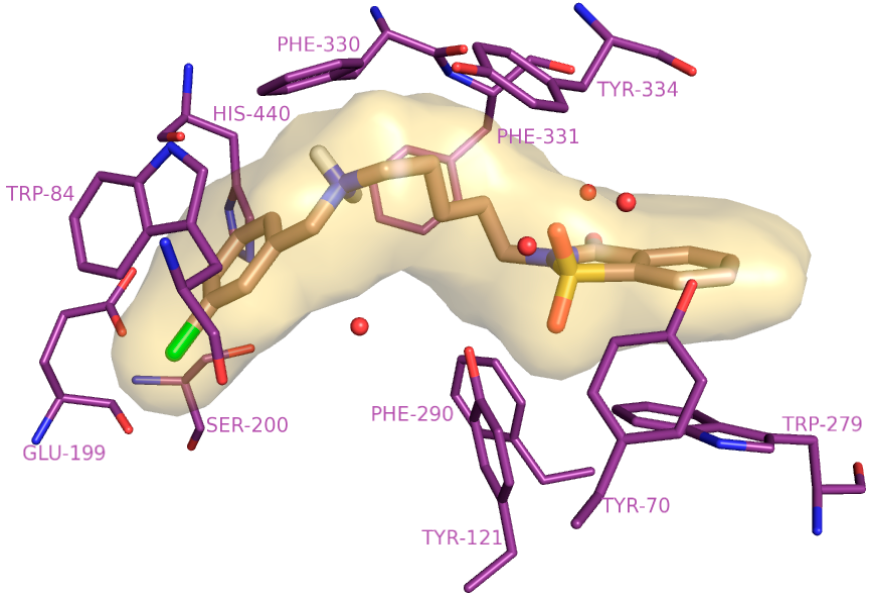
Figure 5. The binding mode of compound 42 (dark salmon) within the active site of AChE.